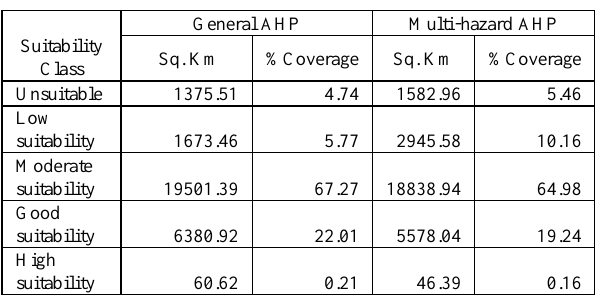
Figure 8. Industrial land-use suitability map of Multi-hazard AHP Table 2. Industrial land-use coverage for different degree